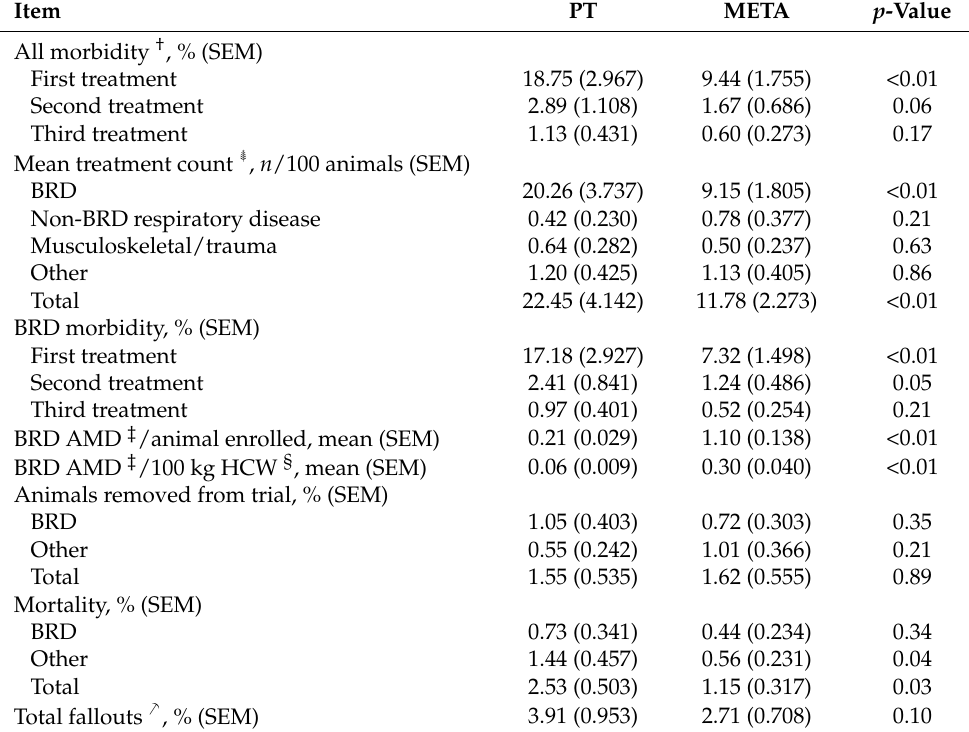
Table 2. Model adjusted means and standard errors of the mean (SEM) for health and antimicrobial use outcomes of steers and heifers at medium risk for bovine respiratory disease (BRD) that received metaphylaxis (META) or a pull-and-treat (PT) health program for BRD *. Item